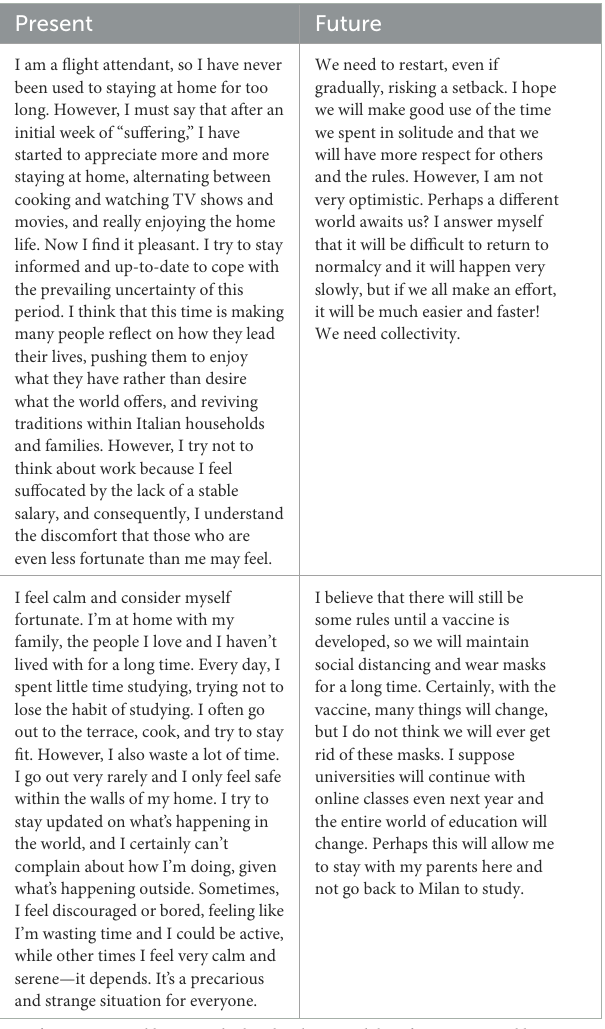
TABLE 1 Four narratives are reported (two for the present scenario and two for the future scenario) as examples. Present